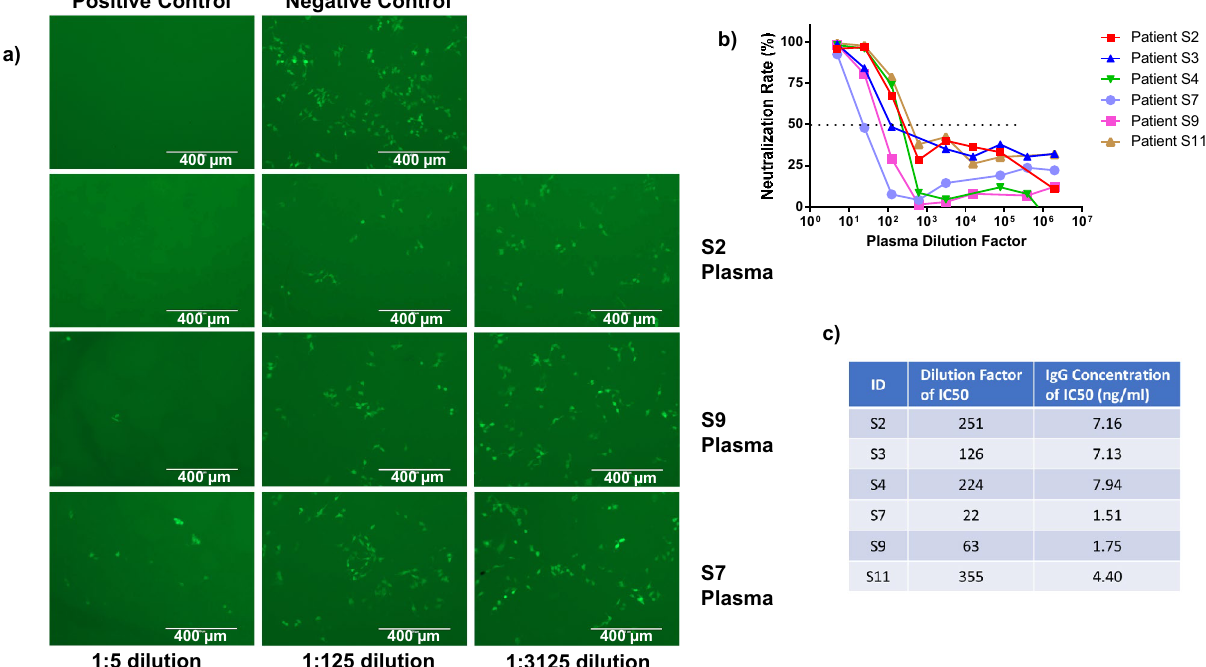
Figure 4. Inhibition of SARS-CoV-2 infection by COVID-19 convalescent plasma. ( a ) Representative fluorescent images showing inhibition of SARS-CoV-2 infection by convalescent patient’s plasma. Negative and positive controls of PsV infection into 293 T/ACE2 target cells are shown. ( b ) Neutralization assays showing that COVID-19 convalescent plasma inhibits SARS-CoV-2 S PsV infection. ( c ) The dilution factors of patient plasma and their corresponding concentrations of anti-S1 IgG antibodies are shown. The graph in b was created by Prism 6.01 software (https ://www.graph